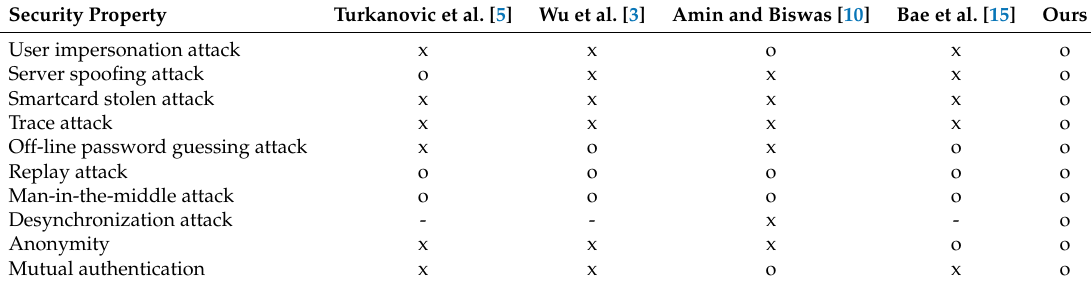
Table 6. Security